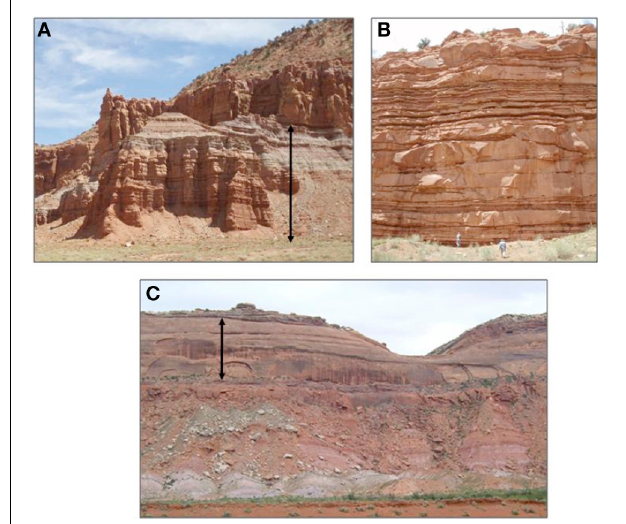
FIGURE 1 | (A) Moenave Formation at Potter Canyon, AZ, indicated by the arrow; (B) Moenave Formation at Tom’s Canyon, Kanab, UT; (C) Wingate Sandstone at Comb Ridge, UT, indicated by arrow [photo credits: (A,B) A. McCall; (C) S. Daman].